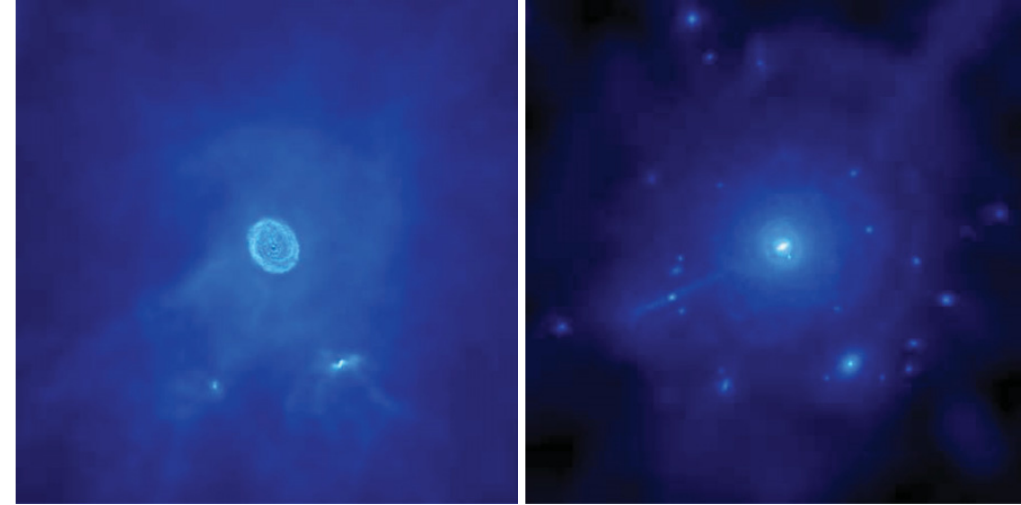
Figure 1. Projected gas (left panel) and stellar (right panel) mass maps of Aq-C-5